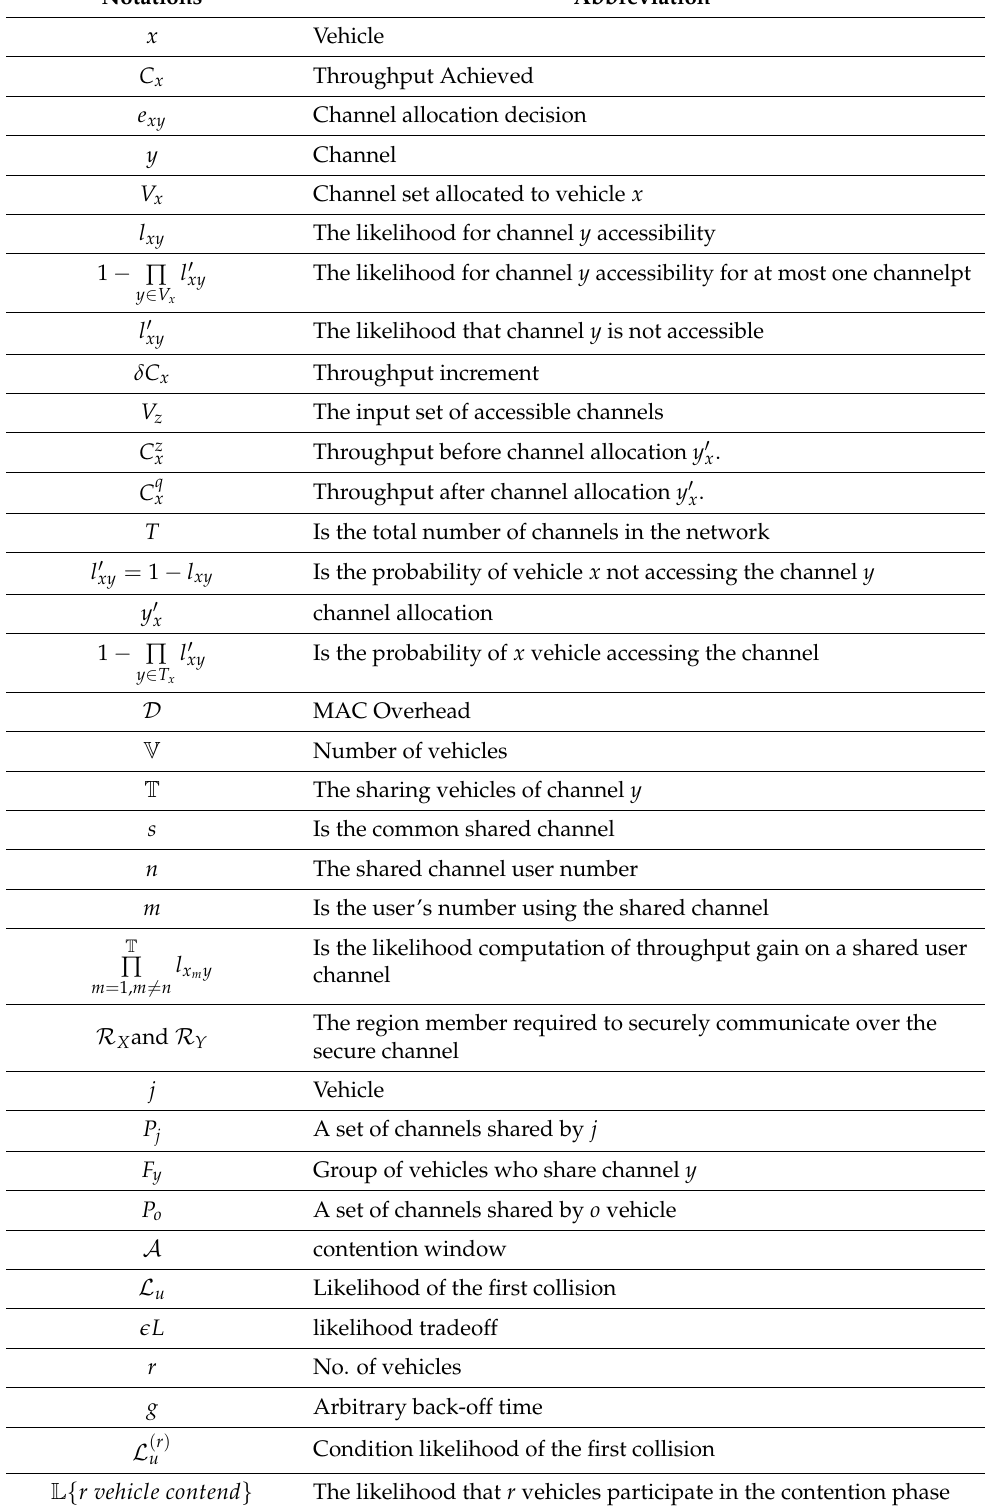
Table 2. Variable